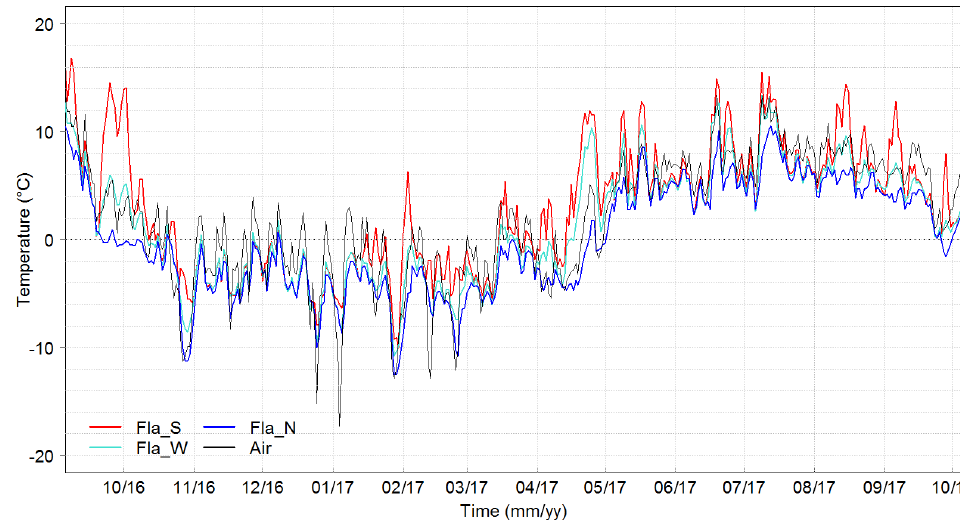
Figure 3. Example of daily rock surface temperature data for the site of Flåm during one hydrological year.